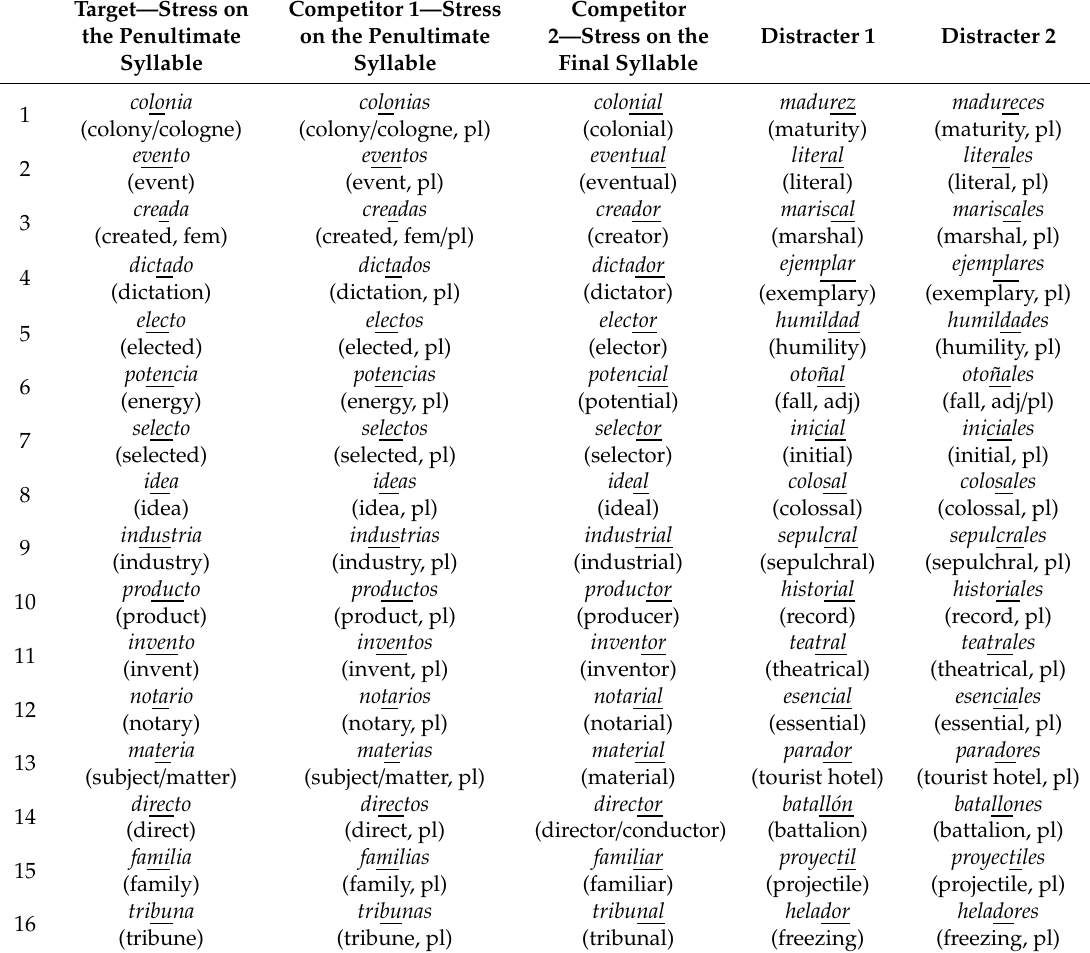
Table A2. List of experimental and distracter stimuli in the cognate condition. Remember that the presence of the competitors was randomized in two lists. While in List 1 a participant saw the pair colonia-colonias , in List 2, participants would see colonia-colonial